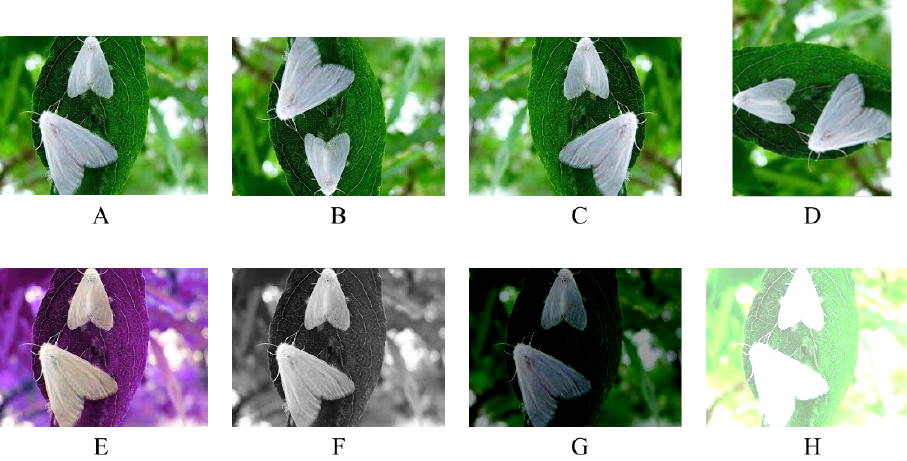
Figure 5. Illustration of different enhancement methods. ( A ) is the original image, ( B ) is vertical flipping, ( C ) is horizontal flipping, ( D ) is 90 degree rotation, ( E ) is hue adjustment, ( F ) is saturation adjustment, ( G , H ) are brightness